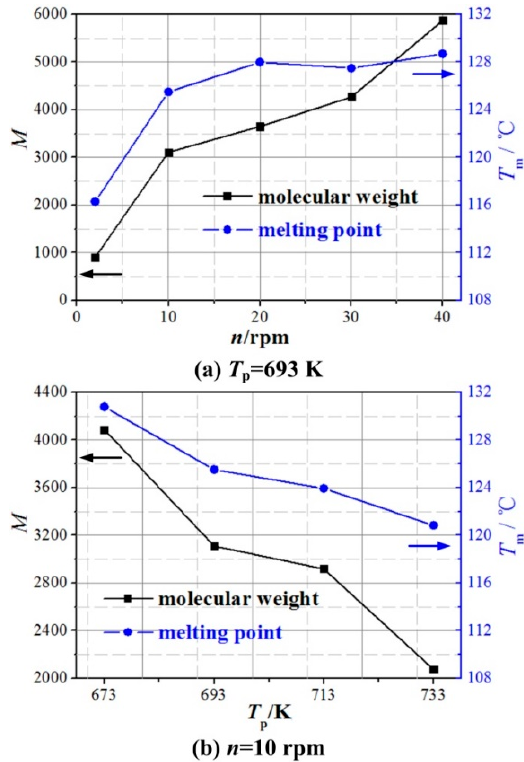
Figure 4. Effects of screw speed and pyrolysis temperature on the number-average molecular weight (NAMW) and melting point of PEW. ( a ) screw speed, ( b ) pyrolysis temperature.